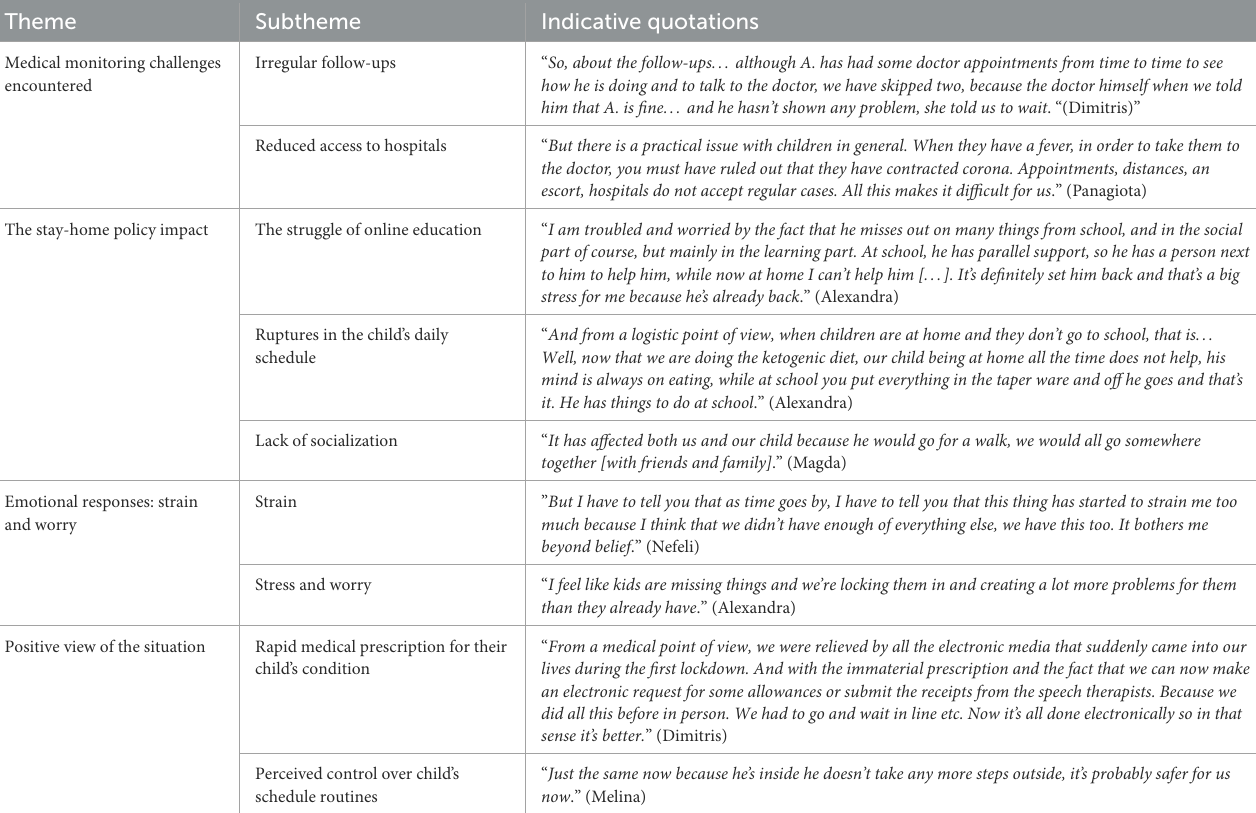
TABLE 2 Emerged themes and subthemes.